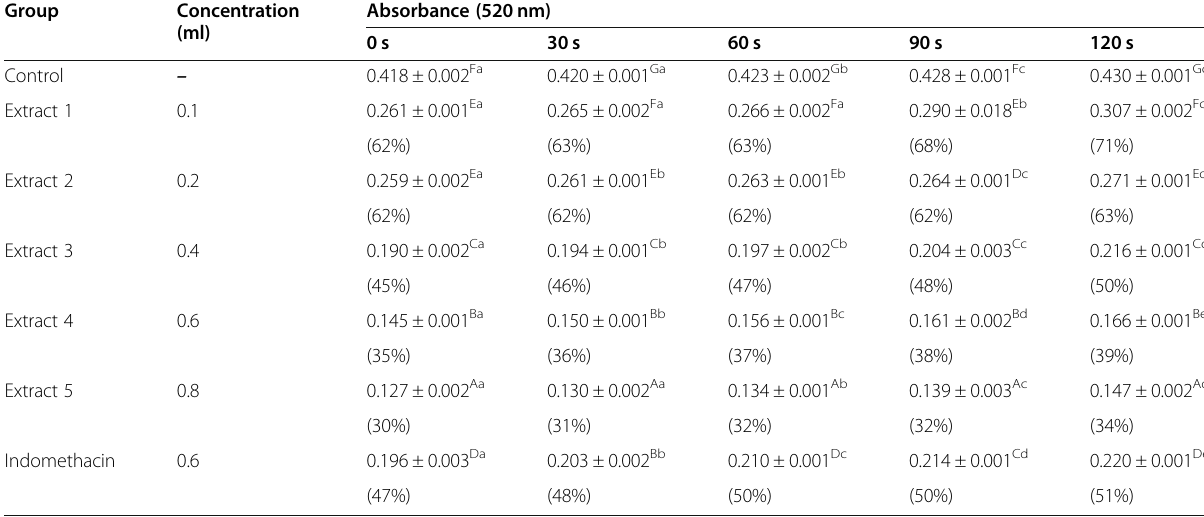
n =3 Absorbance; Results expressed as Mean±Standard Deviation. Mean values having Different uppercase letters as superscripts are considered significant ( P < 0.05) down the column. Mean value having different lowercase letters as superscripts are considered significant across the row. ()=% Inhibition of Platelet